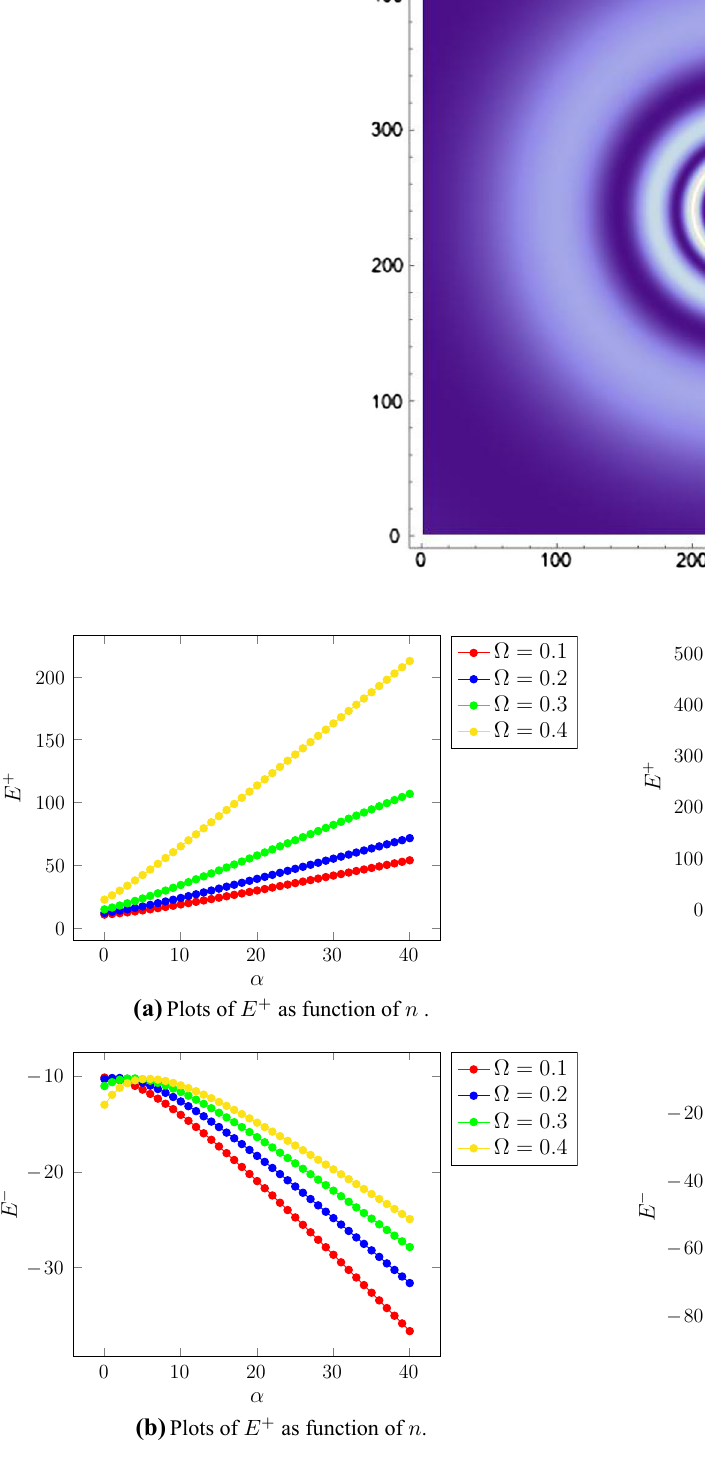
Fig. 1 The wave function probability density in the curve space. The constant are n = 5 , k = 1 ,α = 0 . 5 ,(cid:10) = 0 . 05 , R = 1 , M = 10 , m = 1